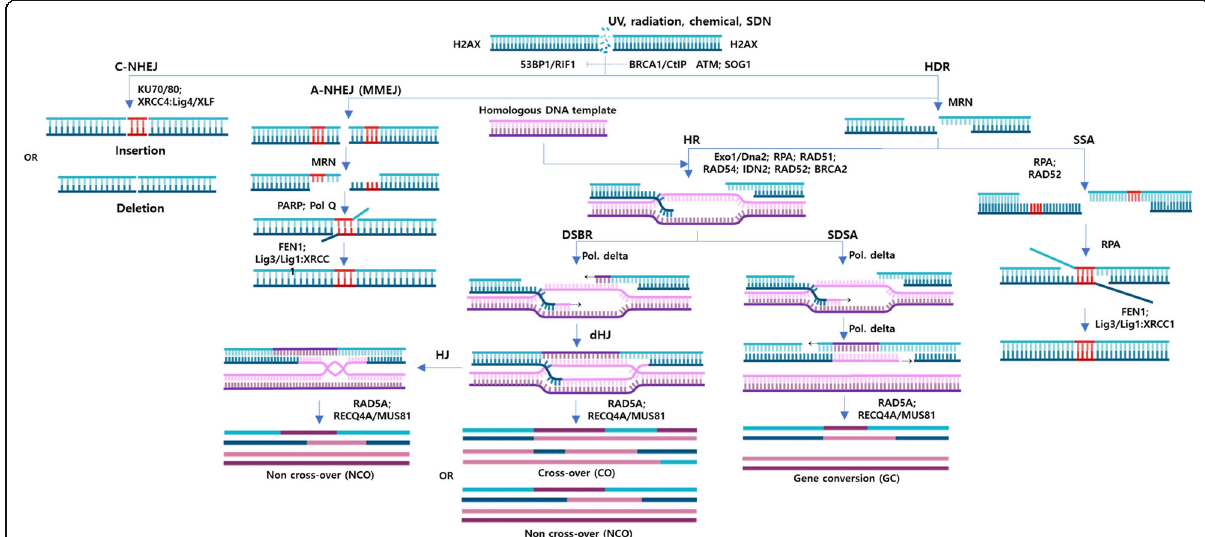
Fig. 1 DSB repair pathways.1017In the C-NHEJ pathway, DSB formation induces binding to broken ends by KU70/80 heterodimers that subsequently recruit the DNA damage response kinase (DDK) complex such as DNA-PKcs in mammals. DDK then activates the 53BP1/RIF1 complex, which plays a role in shielding the broken ends from resection by antagonizing BRCA1/CtIP activity. DNA-PK also activates other KU-recruited proteins, such as XLF, XRCC4 and Lig4, for ligating the broken ends. In the HDR pathway, DSB formation induces cell cycle arrest initiated with the activation of ATM resulting from sensing a chromatin structure change. Activated monomeric ATM then phosphorylates the MRN complex and P53/SOG1, which regulates the cell cycle checkpoint and arrest. MRN activation supports end resection for HDR. Limited resection leads to MMEJ, and if a substantial level of resection is formed in the absence of a donor template, SSA is likely to be used for the repair. MMEJ requires PARP and Pol Q for its processes, and SSA requires the role of RAD52. Both MMEJ and SSA require the ssDNA flap endonuclease FEN1 and Lig3/Lig1:XRCC1 for ligating final products. Extensive resection of the broken ends is facilitated by Exonuclease 1 (Exo1) and/or Dna2. In the presence of donor template, the 3 ′ overhangs of resected ends could be protected by RPA binding and then recruiting RAD51 to the ssDNA with support and control by BRCA2. RAD51 binds to the resected ssDNA overhang, forming nucleoprotein filaments or presynaptic filaments. With the support of RAD54, the filament structure invades the donor template sequence and searches for and anneals to the complementary sequence; then, displacement loop (D-loop) formation occurs. Subsequently, the free 3 ′ OH end of the invaded ssDNA primes donor template-dependent DNA synthesis. This process determines the outcomes of HDR with several sub-pathways (DSBR with dHJ and SDSA) with the supportive activity of RAD5A, RECQ4A and MUS81. The DNA fragments and protein structures are not pictured to scale. The potential proteins involved in the processes of each pathway or sub-pathway are denoted adjacent to their approaching lines. XRCC: X-ray repair cross-complementing protein; XLF: XRCC4-like factor; Lig4: DNA ligase 4; PARP: poly-ADP-ribose polymerase; Pol Q: DNA polymerase